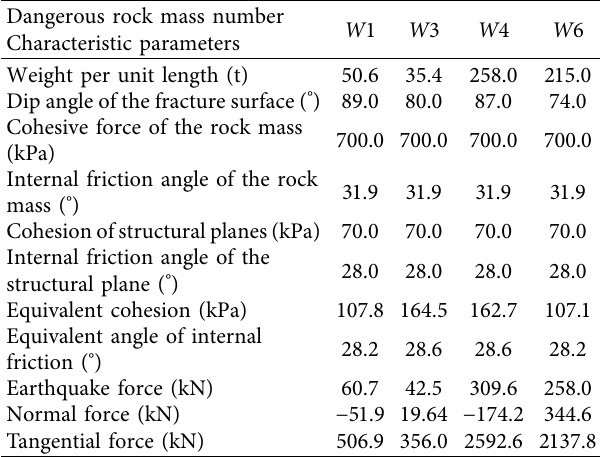
Figure 12: Tipping-type dangerous rock mass of W 5. Table 4: Characteristic parameters of falling-type dangerous rocks.